Question: What kind of plot is shown here?
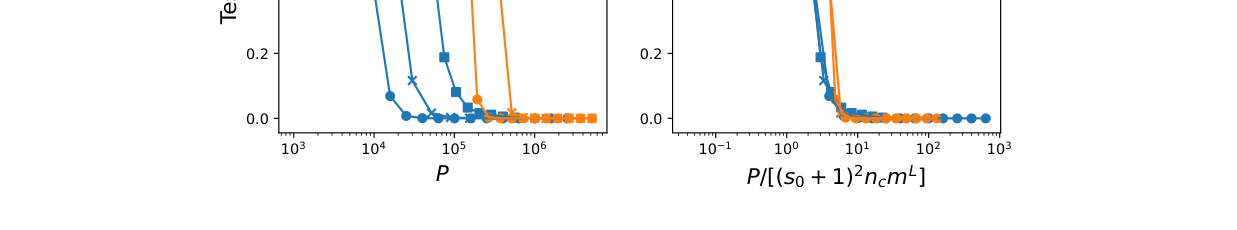
Answer: line